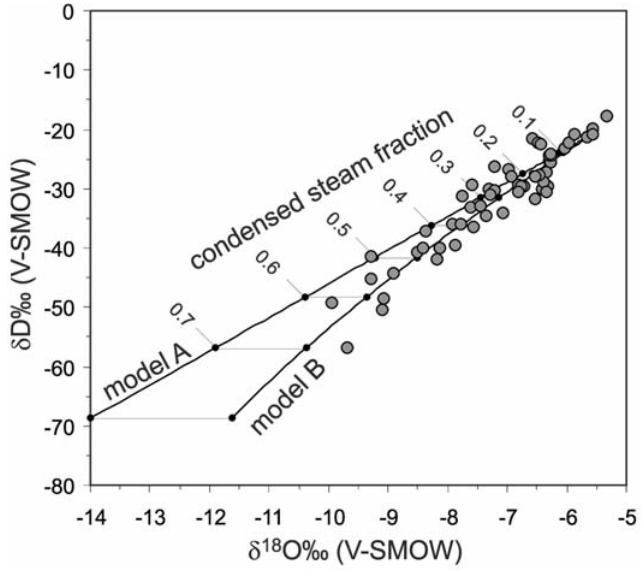
Figure 6. Plot of d D vs. d 18 O of the fumarolic condensates (fumarole FC2). Condensation models under near discharge conditions (94.5 ˚C) are also reported, with the parent fluid sample of 22/08/2007. Model A refers to simply multistep steam condensation, while model B refers to multistep steam condensation that takes into account the oxygen isotopic exchange between and water vapor during the process. The good fitting of the analytical and CO 2 theoretical (model B) data support the possible occurrence of this process.